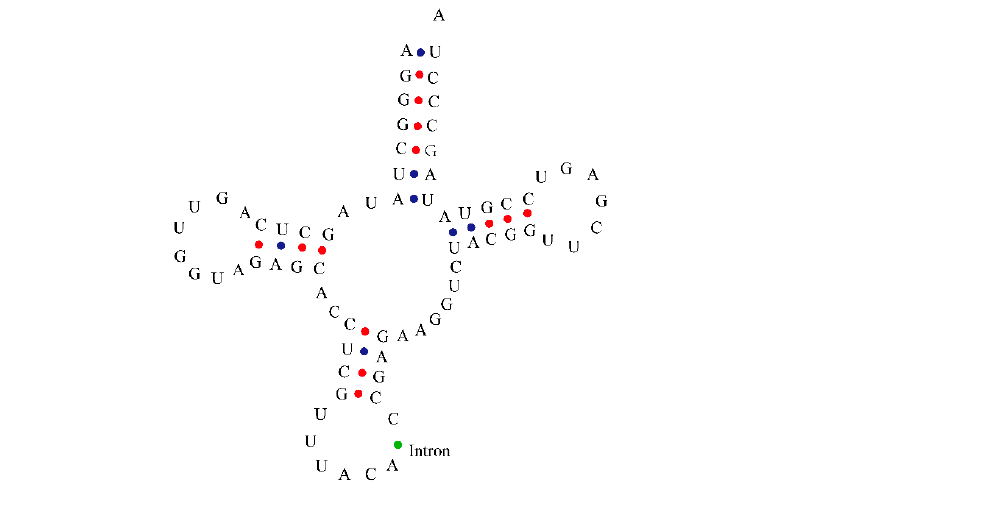
Figure 1. Presence of intron in chloroplast tRNA, found to be located in the tRNA anti-codon loop. The blue dot represents dihydrogen bonds; the red dot represents triple hydrogen bond; and the green dot indicates the position of intron.